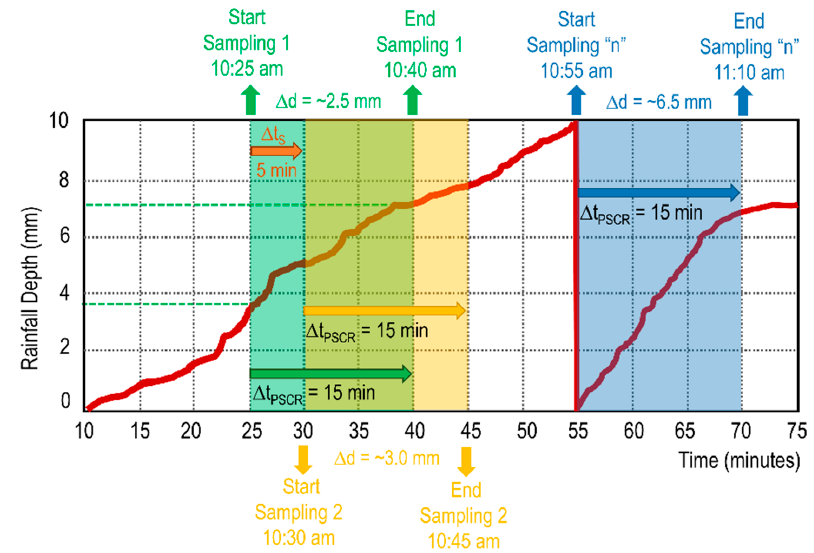
Figure 4. An exaggerated example of the reading process performed by PSCR to obtain maximum rainfall intensities. The rainfall depths (heights) estimated by the PSCR are calculated using an accumulation interval of 15 min ( ∆ t PSCR ). The selected sampling interval (time step) for the calculation of maximum rainfall intensities is 5 min ( ∆ t S ).